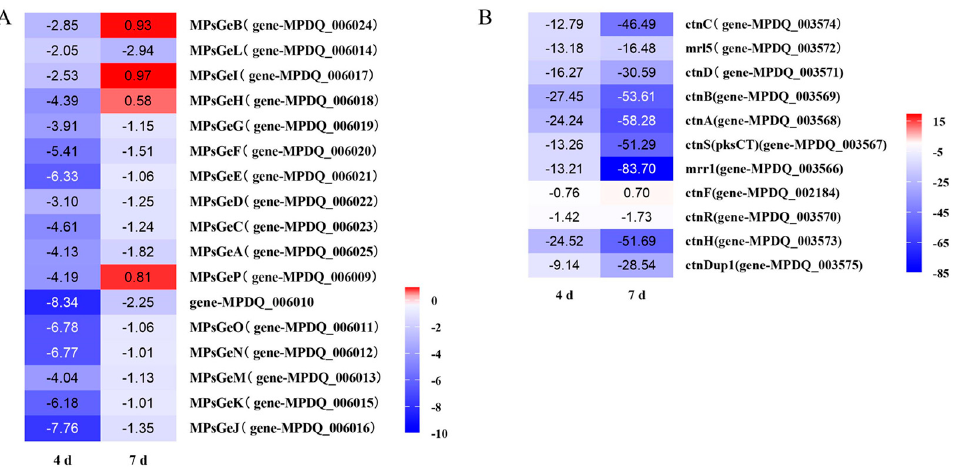
Figure 8. The changes in mRNA levels of Monascus pigments’ biosynthetic gene cluster ( A ), and citrinin biosynthetic gene cluster ( B ) after knocking out the chs 6 gene in the parent strain M. purpureus LQ-6 during the submerged fermentation at the fermentation prophase (day 4) and the logarithmic stage of fermentation (day 7).